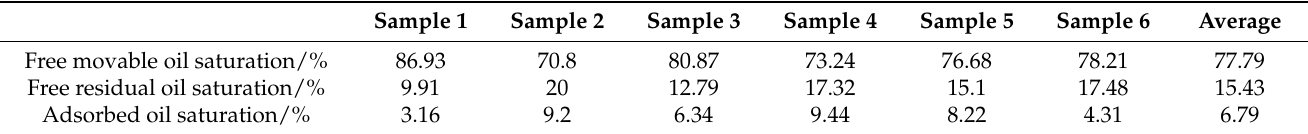
Table 2. Saturation of various fluid components in six